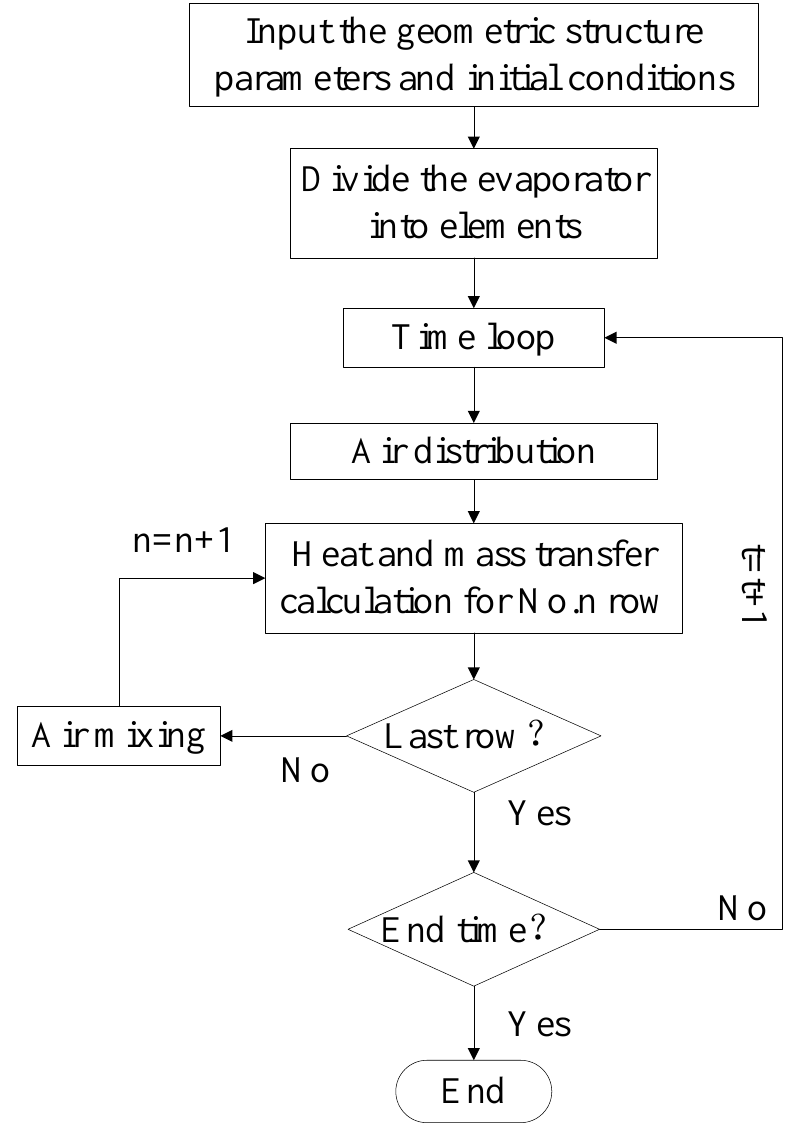
Figure 3. Algorithm flow chart of the model solution.